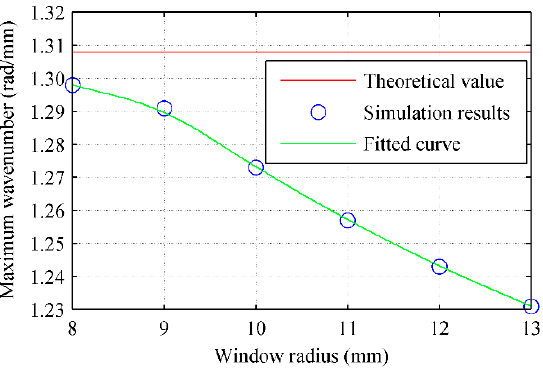
Figure 10. The maximum wavenumber obtained under various window radii. The central frequency of the excitation signal is 200 kHz.